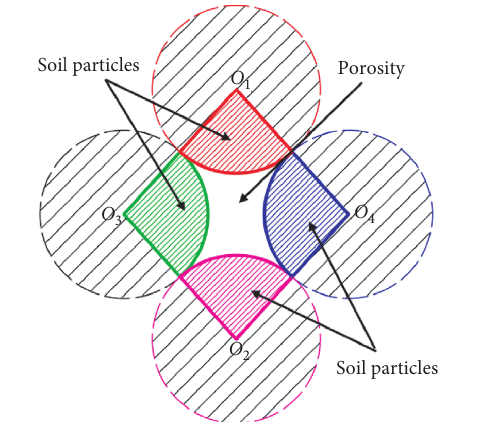
Figure 17: The cross-section of the unit